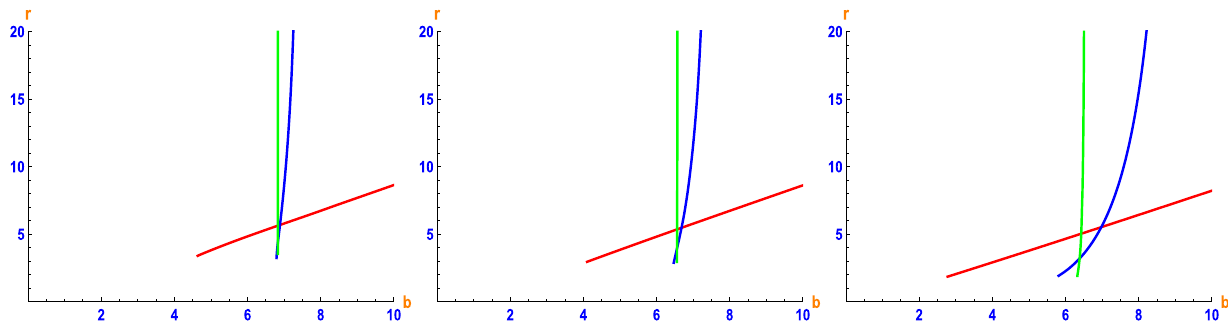
Fig. 4 The relationship between different trajectories of photons and impact parameter b , for specific values of model parameters in polar coordinates ( r ,ϕ) . Here, the spacings of b are 1 / 5, 1 / 100, and 1 / 1000 for direct emission, lensing, and photon ring corresponds to red, blue,